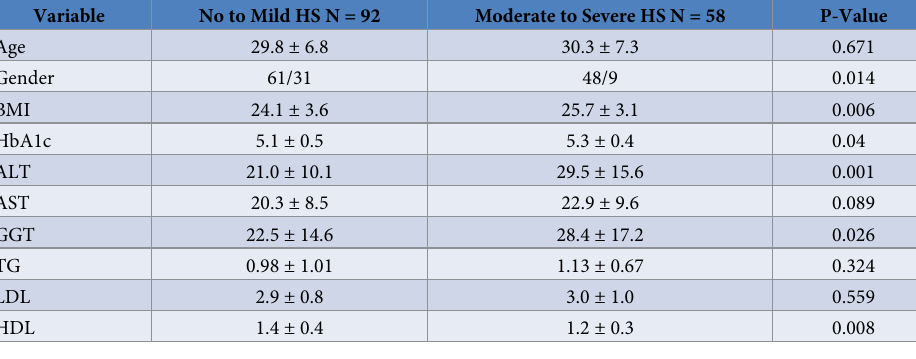
Results are given as means ± SD